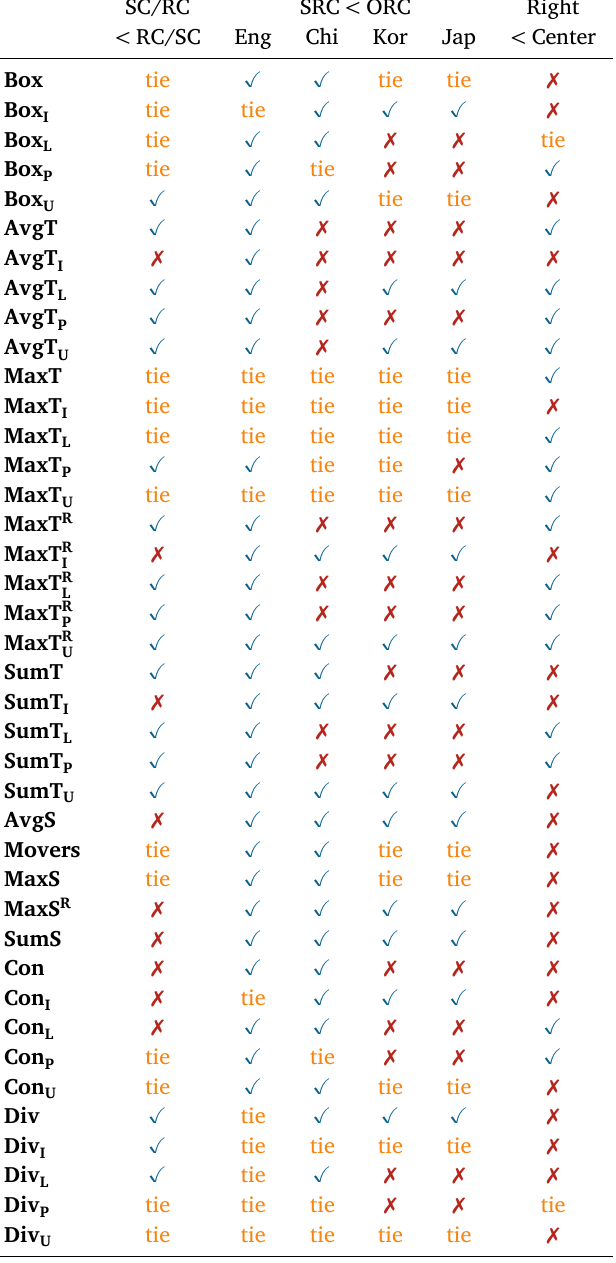
Table 1: Predictions of complexity metrics with promotion